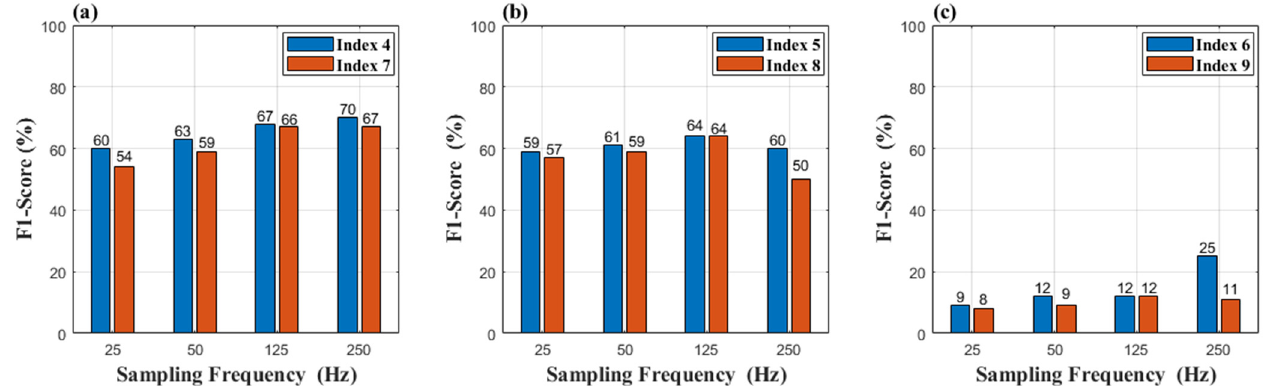
Figure 7. ( a ) Result of Indices 4 and 7 ( b ) Result of Indices 5 and 8 ( c ) Result of Indices 6 and 9.